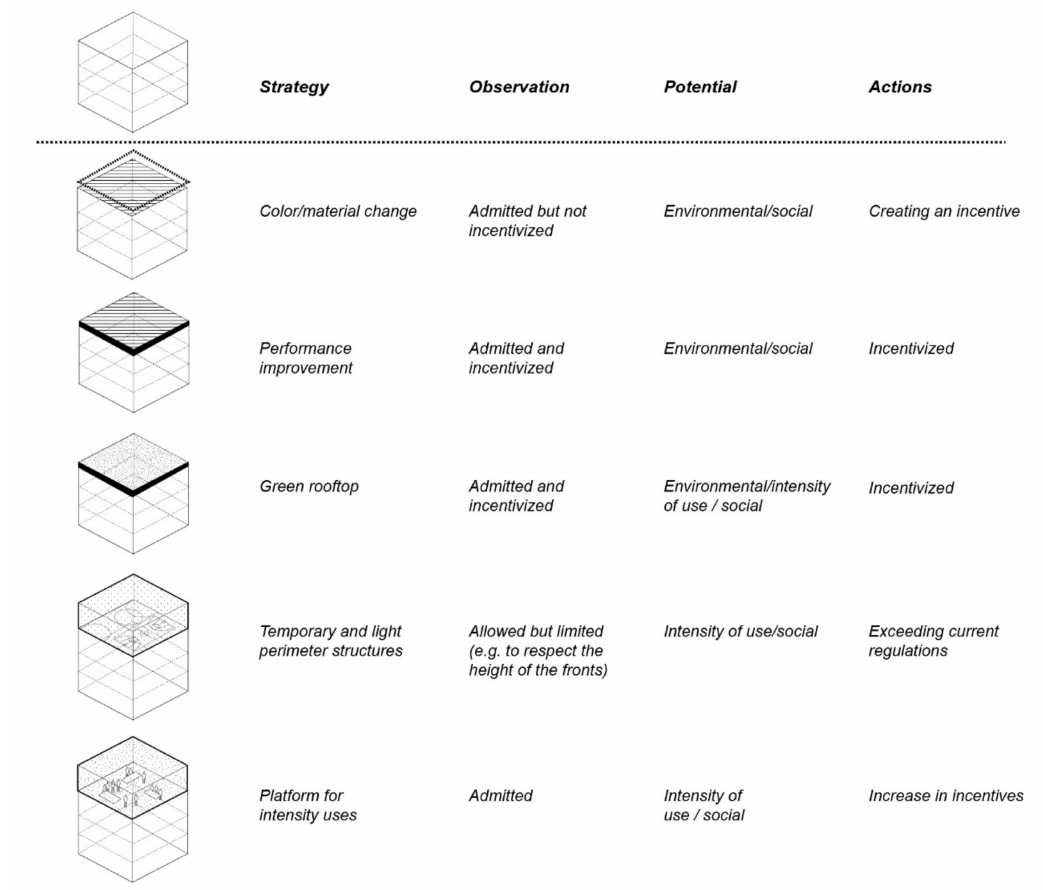
Figure 15. Application of the results: Re-Coding